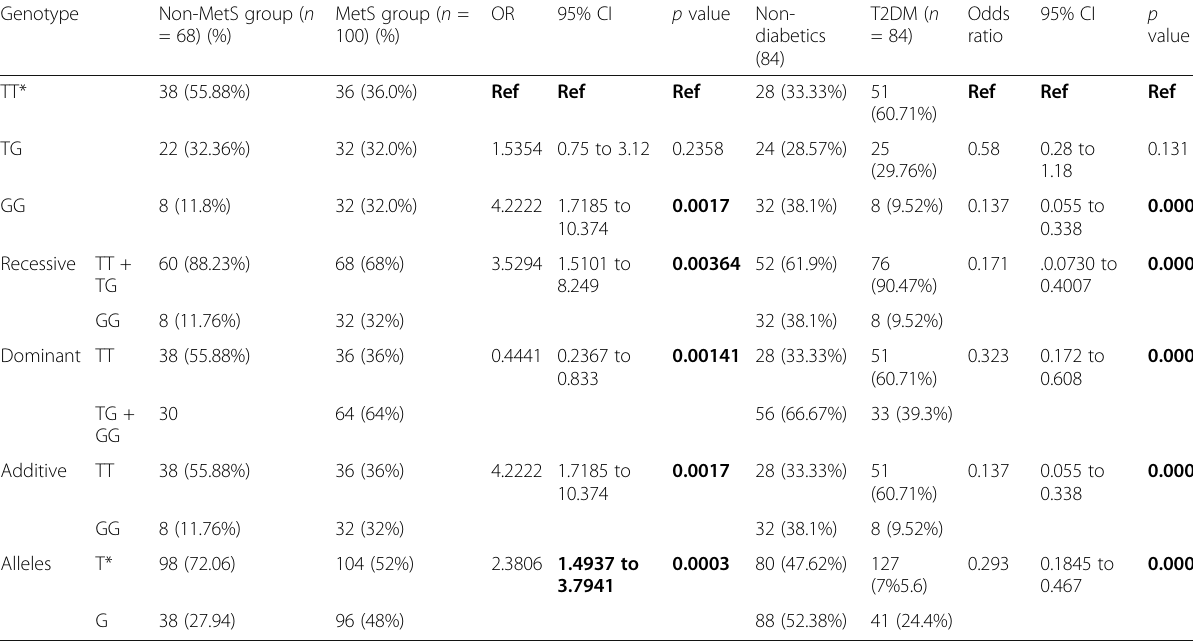
Table 4 Genotyping and allelic frequencies distribution of RARRES2 rs17173608 gene polymorphism between controls (non-MetS) and metabolic syndrome (MetS) group, and between T2DM and non-diabetics patients